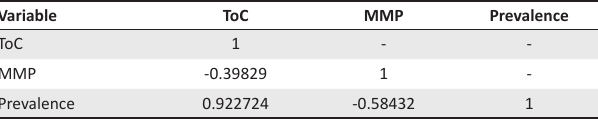
TABLE 2: Relationships between temperature, mean monthly precipitation and malaria prevalence.